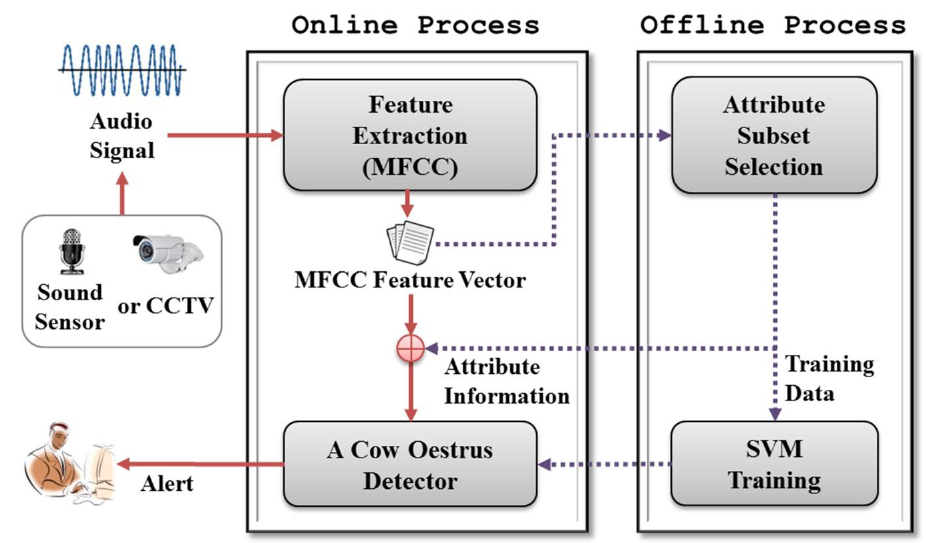
Figure 1. Overall structure of the Korean native cow oestrus detection